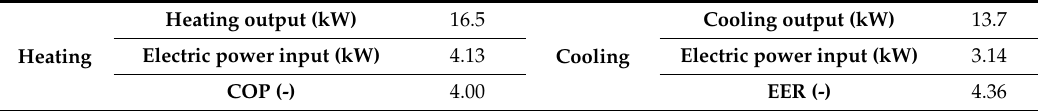
Table 2. Rated ground source heat pump (GSHP) data. COP-coe ffi cient of performance; EER-energy e ffi ciency ratio.